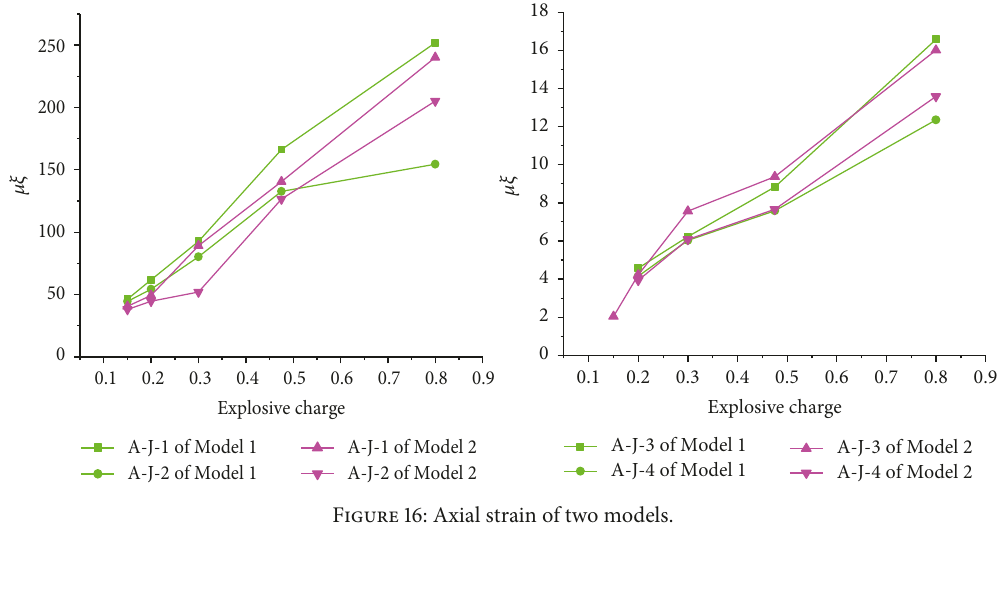
Figure 16: Axial strain of two models.